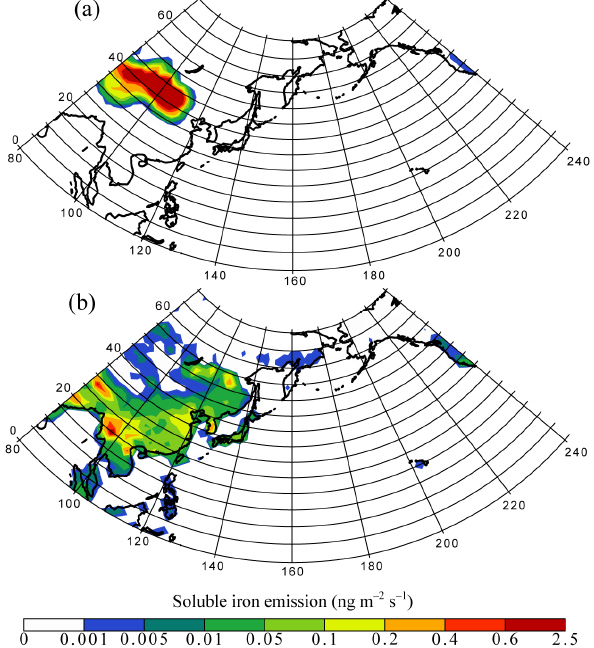
Fig. 1. Spatial distribution of monthly averaged soluble iron emis- sion (ng m − 2 s − 1 ) from (a) desert and (b) combustion sources in